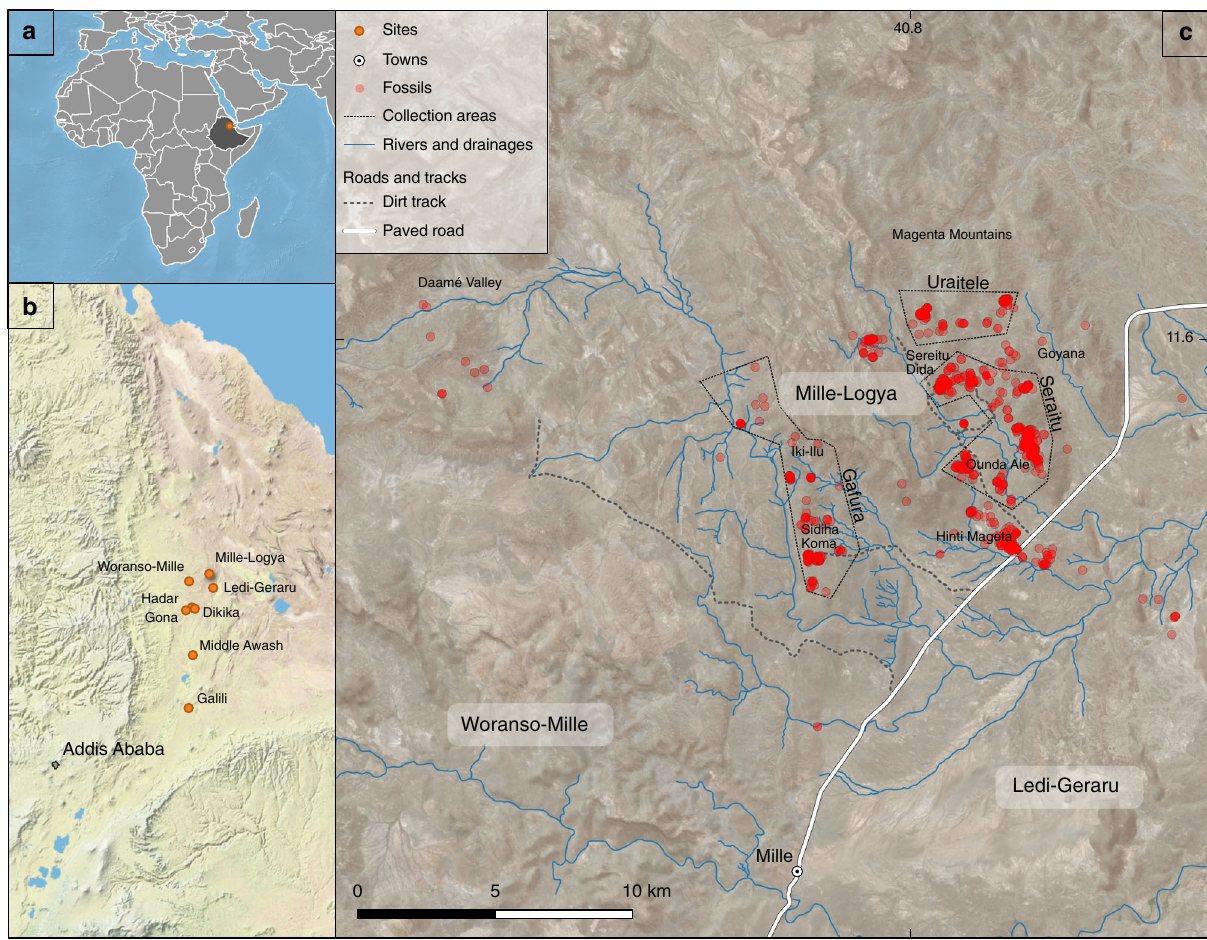
Fig. 1 Location of the Mille-Logya Project (MLP) area within the greater Afar sedimentary basin, Afar, Ethiopia. Panel a shows the location of MLP within Ethiopia; b the localtion of MLP relative to other major Plio-Pleistocene hominin sites in the Afar triangle; c the distribution of individual fossils and the three main collection zones (Gafura, Seraitu, and Uraitele) The maps in this fi gure were generated with the standard distribution of QGIS version